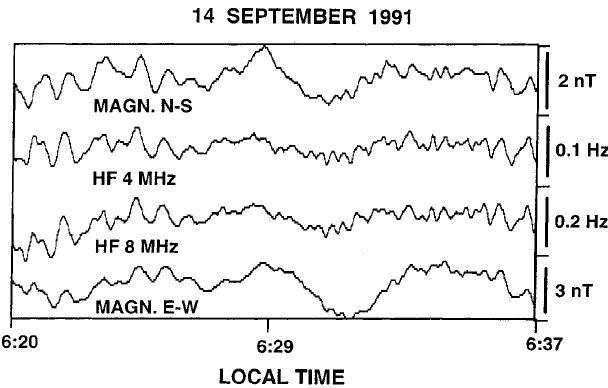
Fig. 2. Typical unfiltered record showing simultaneous oscillations in the ionospheric F-region and the ground-level magnetic field, 0620– 0637 LT (=UT + 10 h), 14 September 1991. Traces are, from top to bottom : north-south magnetometer component ( D H); 4 MHz iono-